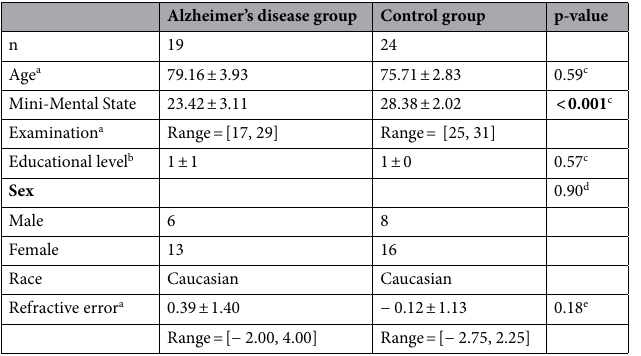
Table 1. Demographic and clinical data of AD patients and controls. a Mean value ± SD. b Median ± interquartile range. c Mann–Whitney two-sided U-test. d Proportions two-sided z-test. e Student’s two-sided t-test. In boldface p-value < 0.05 (SD, standard